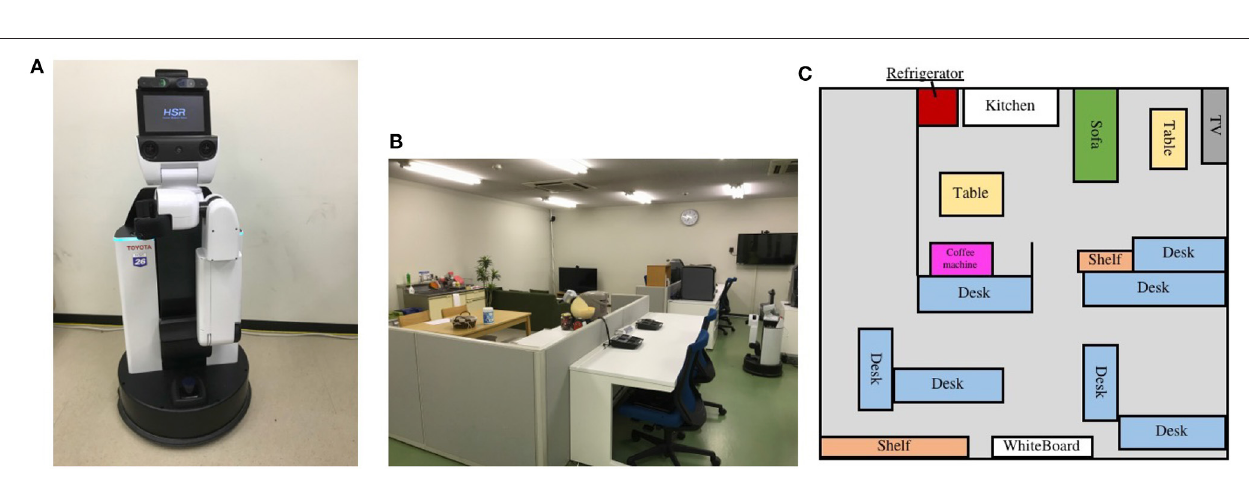
FIGURE 8 | The robot and the example of experiment on the real environment. (A) Robot employed for experiments on the personal living environment. We used the Human Support Robot (HSR) from TOYOTA; it has Xtion PRO LIVE by ASUS to obtain RGB data and UST-20LX by Hokuyo to obtain laser-range data. Ubuntu 16.04 and ROS kinetic were installed on the PC. (B) The image of the environment employed in this experiment and (C) the map of the